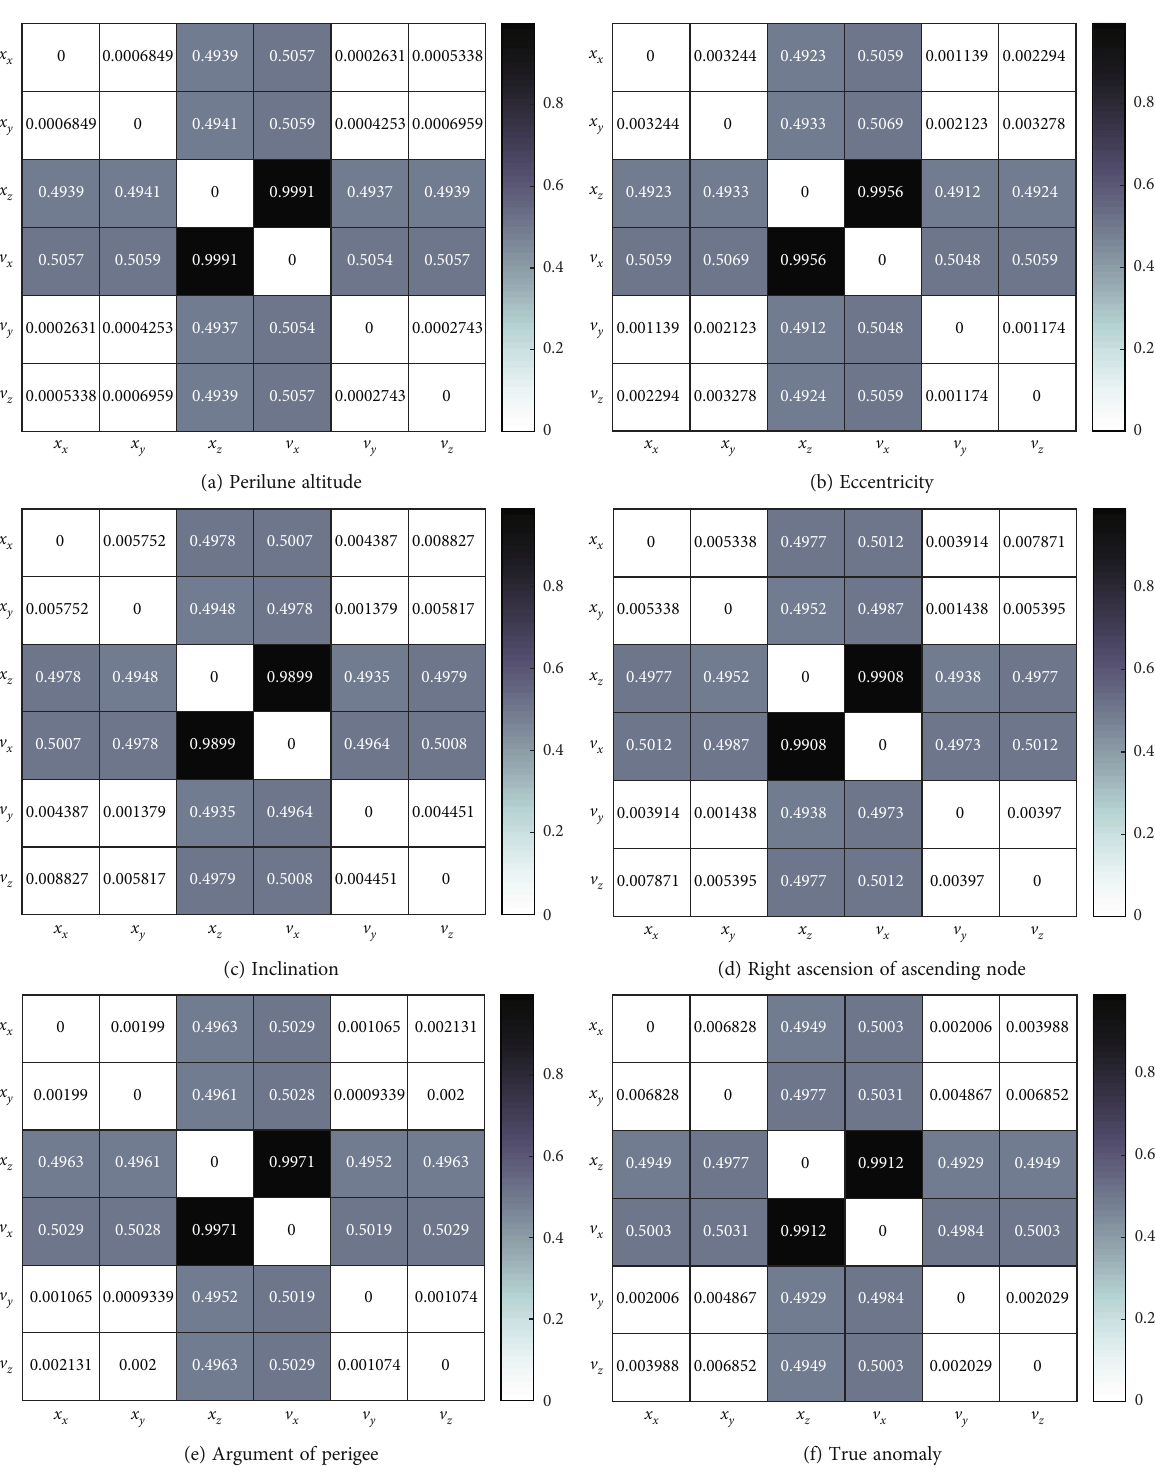
Figure 11: Sensitivity index for combination of position and velocity